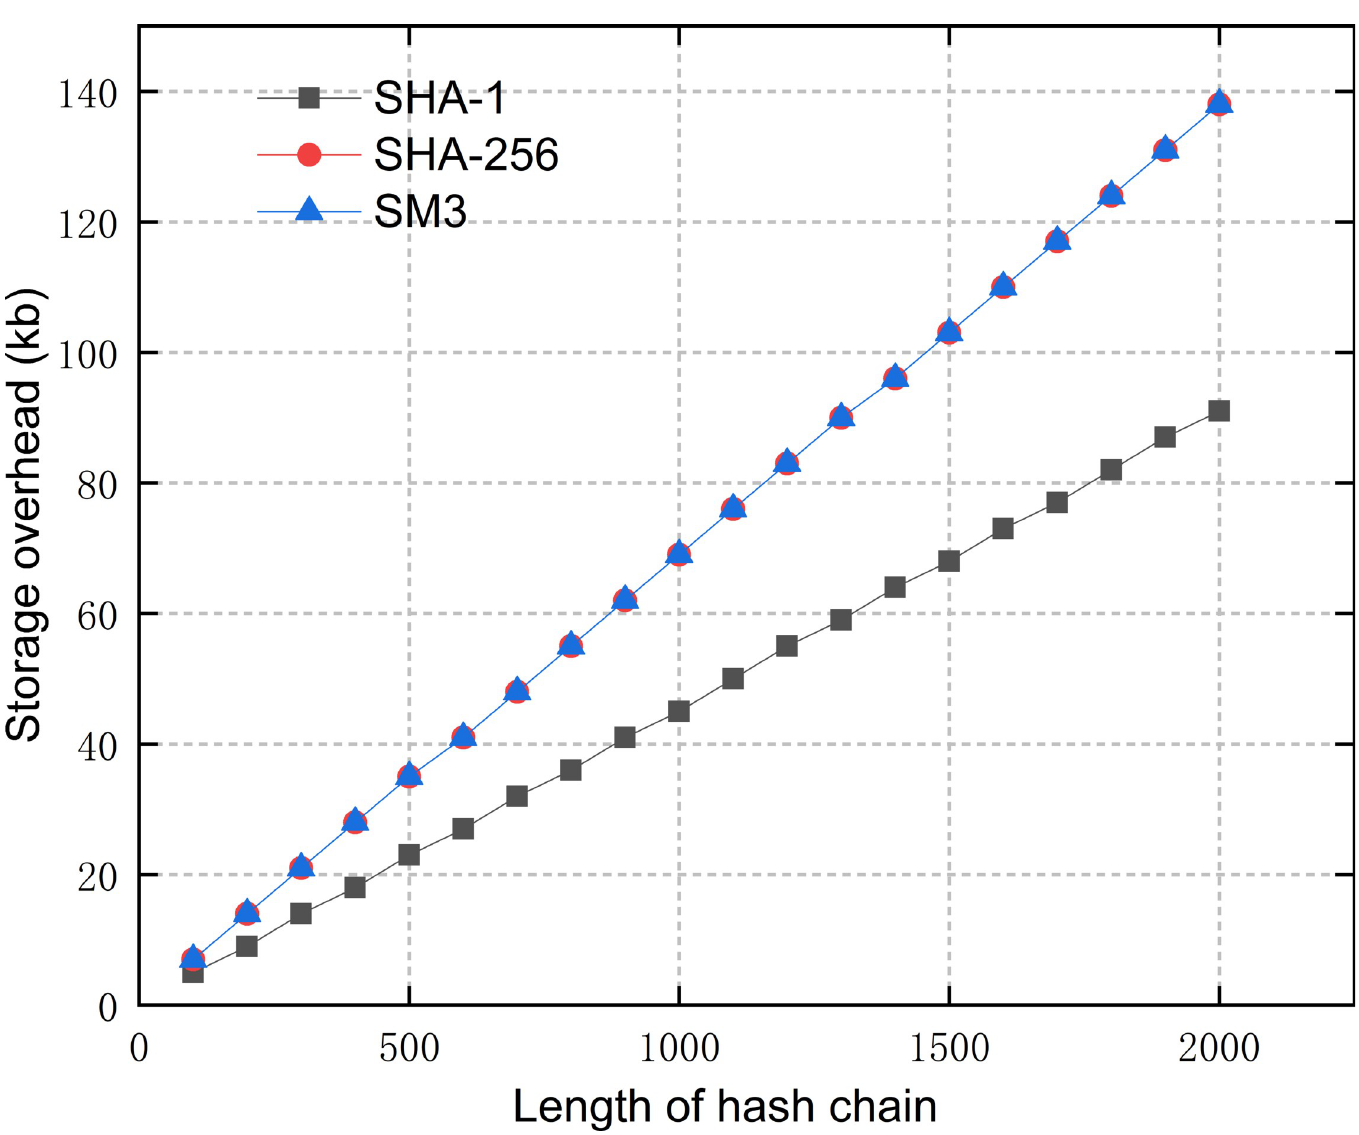
Fig 6. Storage overhead of hash